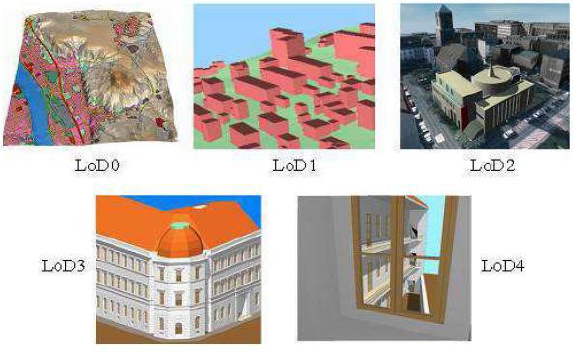
Figure 1: The 5 LoDs (after Kolbe, 2017) Based on the LiDAR points cloud. buildings are vectorized as DGN files. These files together with orthoimages and digital